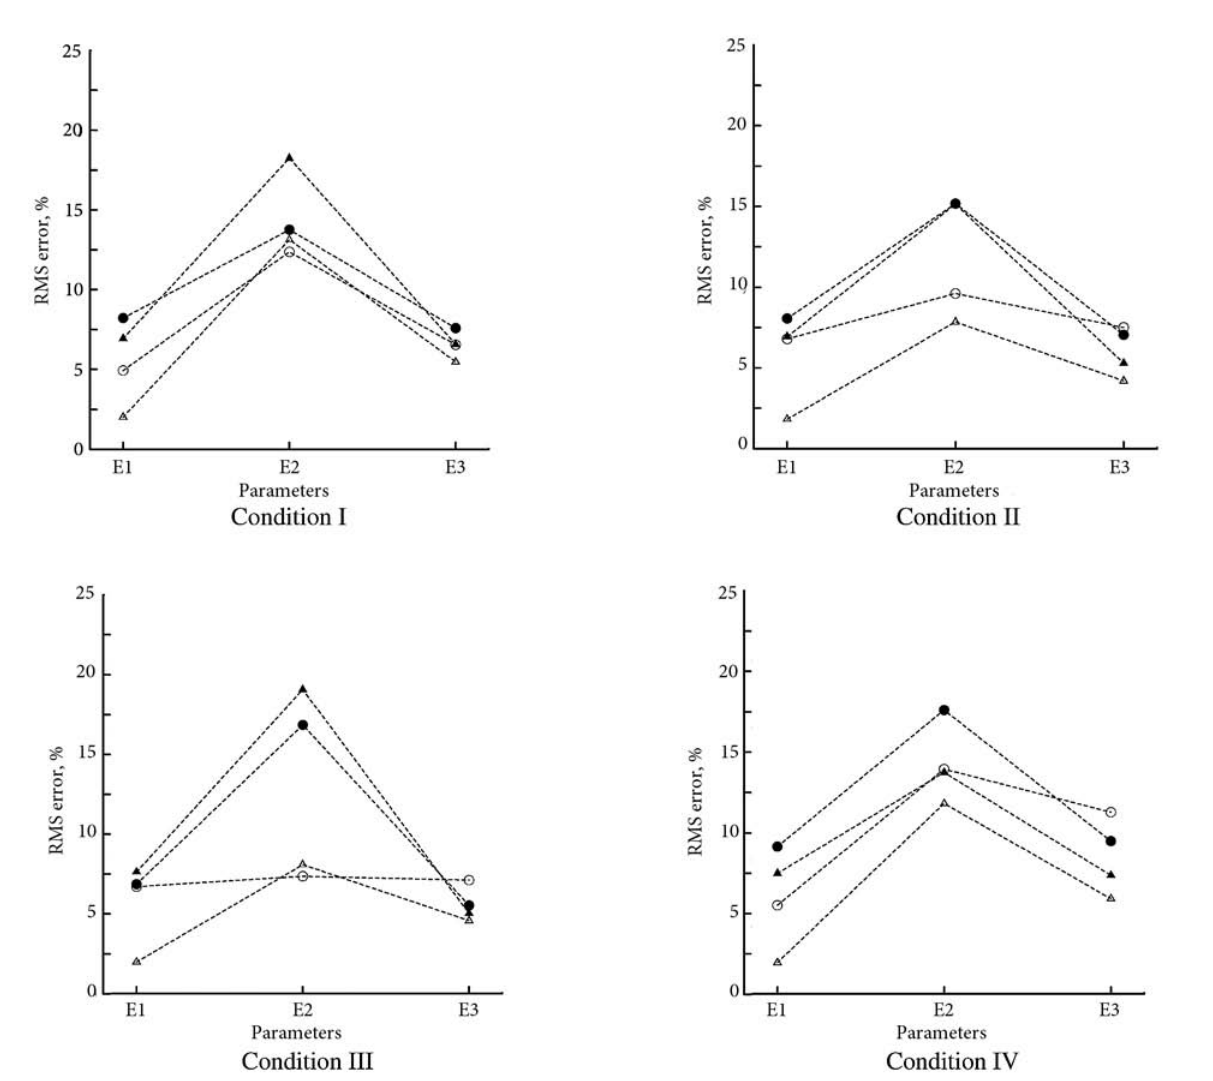
Fig. 5. Comparisons between conventional and proposed NN of estimation error corresponding to integrity condition – bedrock case: proposed NN;